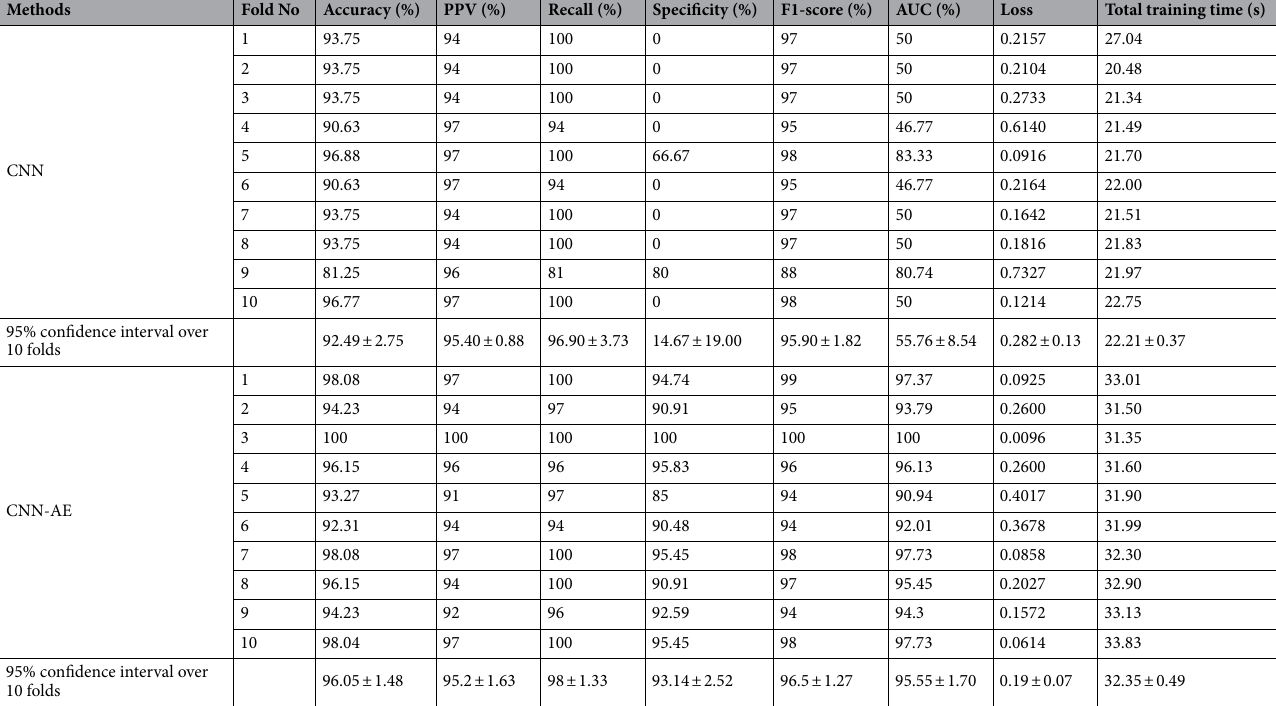
Table 7. Comparison of the CNN and the CNN-AE using different evaluation metrics based on a tenfold cross-validation.